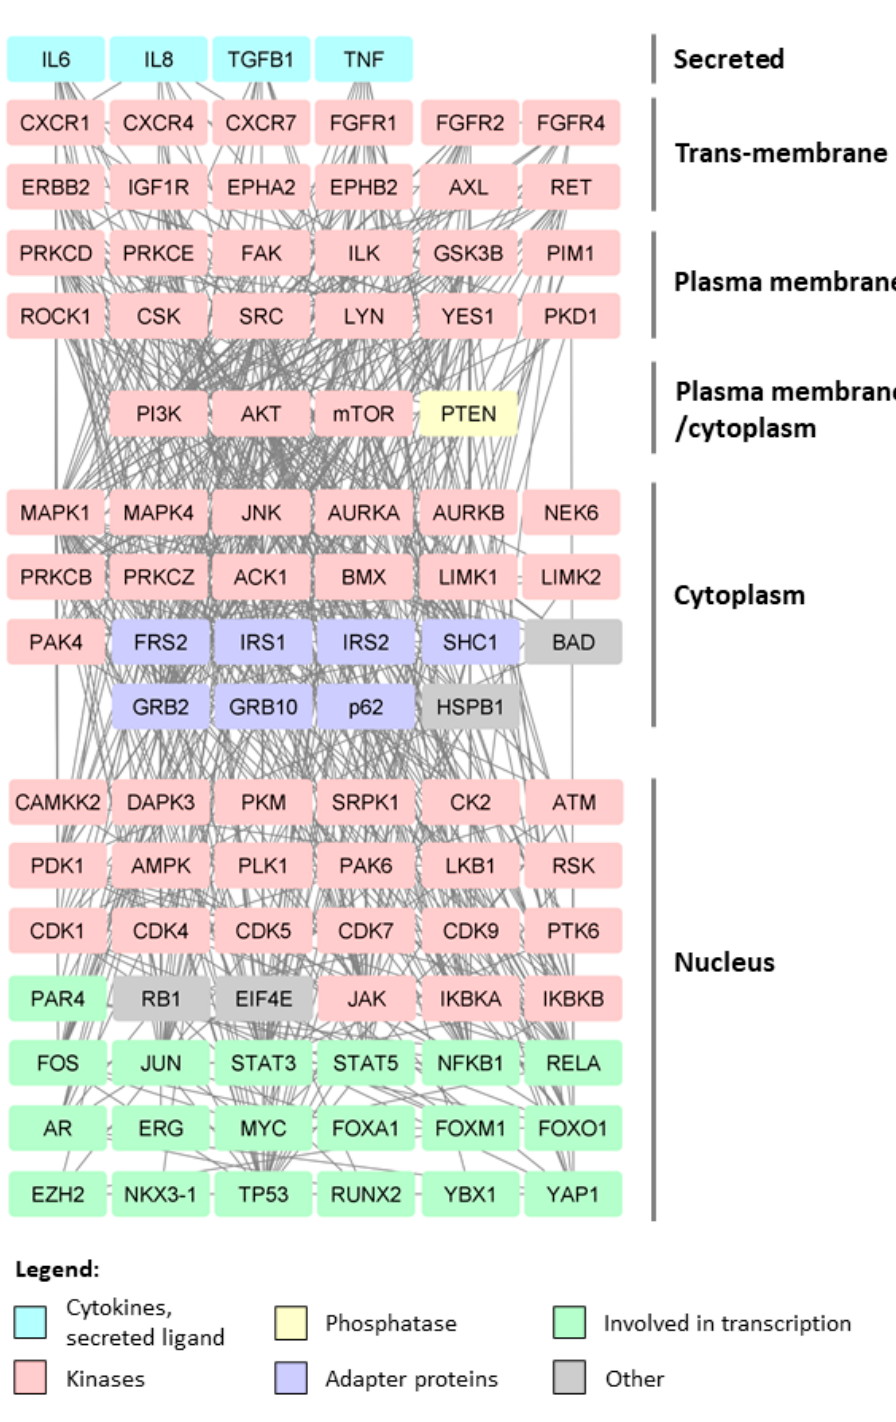
Figure 1. Interaction network of proteins involved in or affected by phosphorylation in prostate cancer. Kinases, adapter proteins, and transcription factors are shown to visualize the network that drives prostate cancer progression. The roles of phosphatases in prostate cancer have been recently reviewed [88] and are omitted from this presentation with the exception of PTEN. Protein–protein interactions were downloaded from the STRING [89] website (experiments and databases interaction sources were used) and visualized in Cytoscape [90]. Proteins were selected based on in vitro and in vivo functional and ex vivo studies.